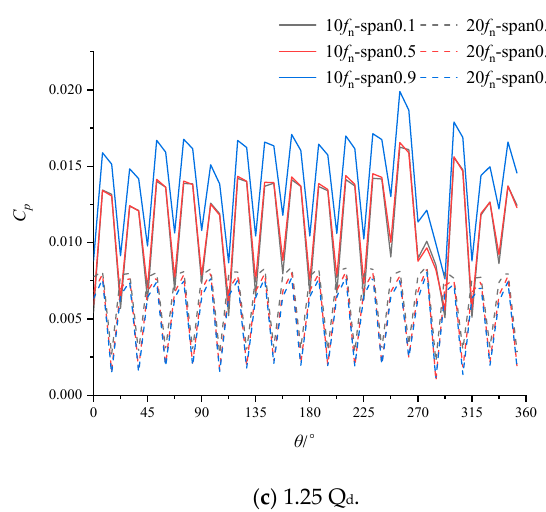
Figure 20. Circumferential distribution of 10 f n and 20 f n amplitudes at different vane heights.